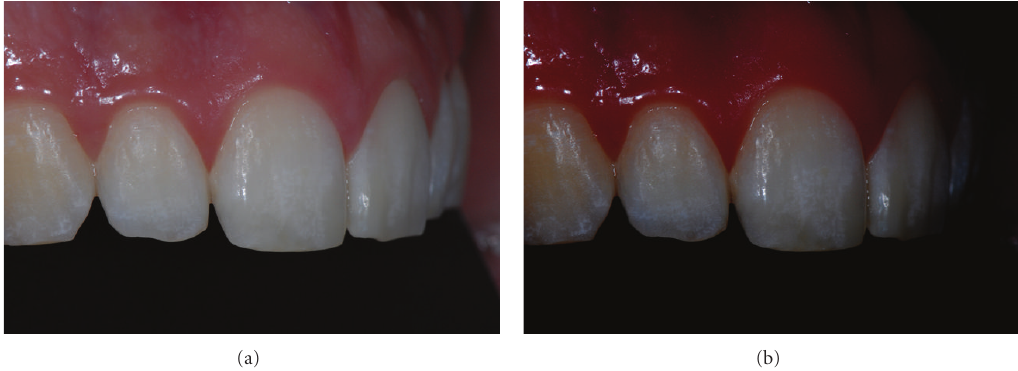
Figure 5: (a) Final right side picture. (b) Software-modified final right side picture.